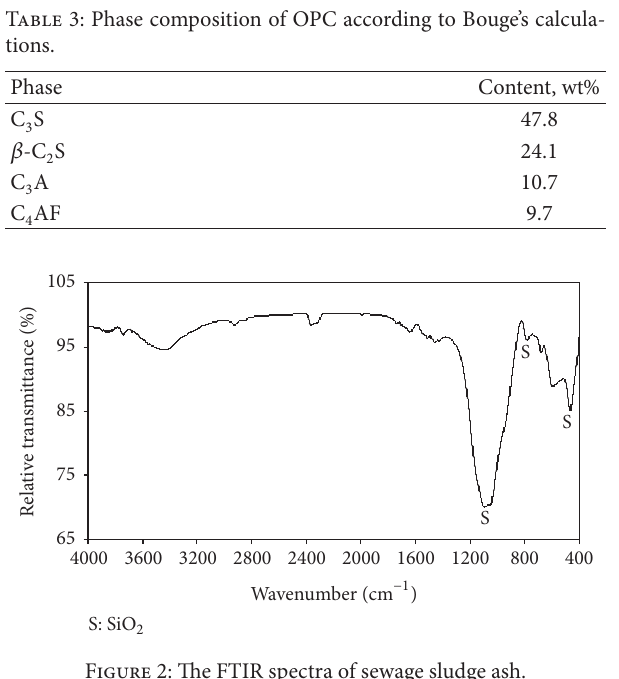
F 2: e FTIR spectra of sewage sludge ash.